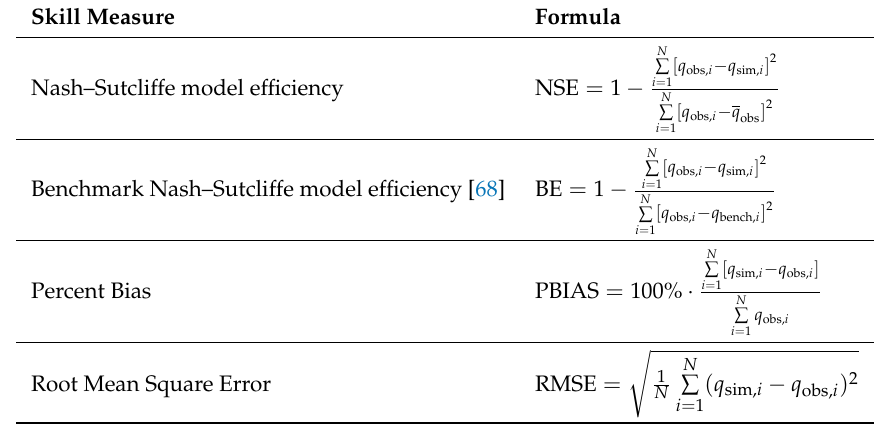
Table A1. Skill measures used throughout the manuscript. Time series of observed q obs and modeled q sim quantities, each consisting of N values, are considered for all time steps t , whereby q represents the mean observed values and q bench is a long-term average computed for the day of obs the year corresponding to time step i , respectively. Skill Measure